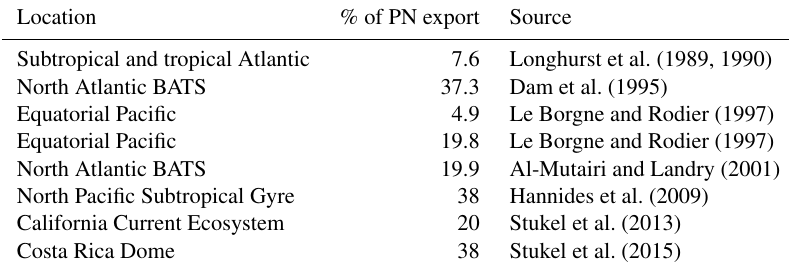
Table 6. Contribution of N export by active zooplankton migration to total PN